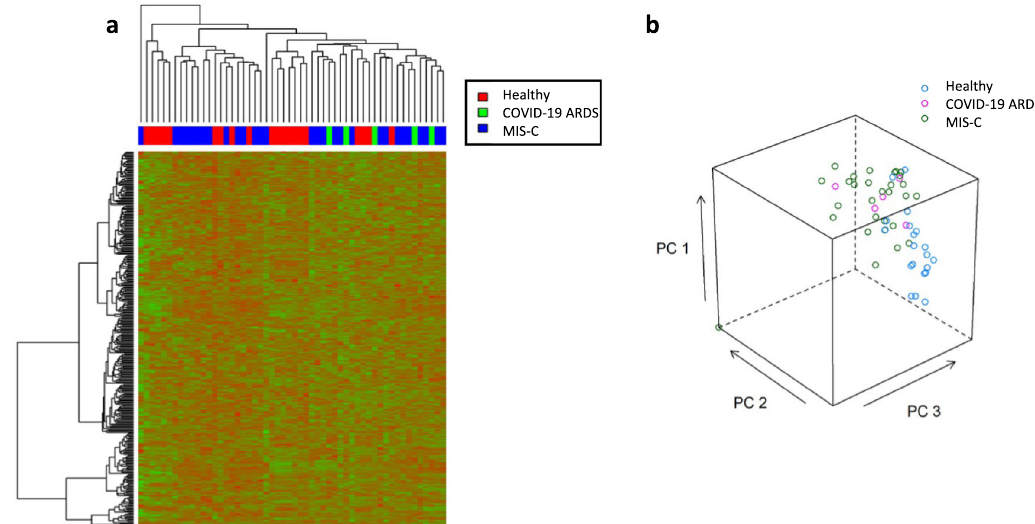
Fig. 1 Hierarchical clustering of all detected proteins. a Unsupervised hierarchical clustering analysis for the 319 protein identi fi cations using the local assay library. Relative expression patterns obtained using Euclidean distance; Green: proteins with decreased expression; Red: proteins with increased expression; b Principal Component Analysis of data from a . The axis of PC1, PC2 and PC3 represented the fi rst three principal components.